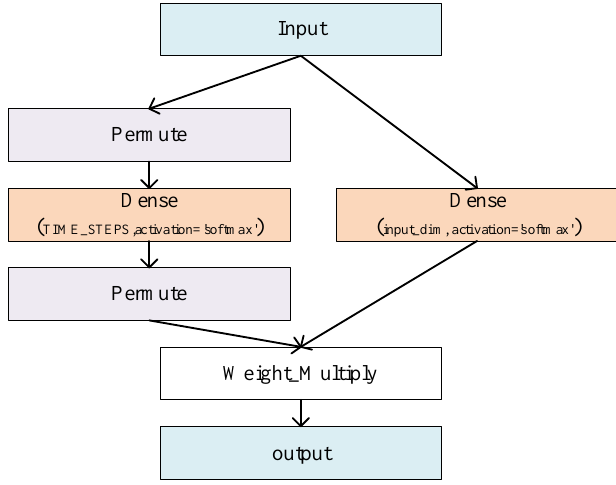
Figure 2. Attention mechanism weights are calculated in this section.